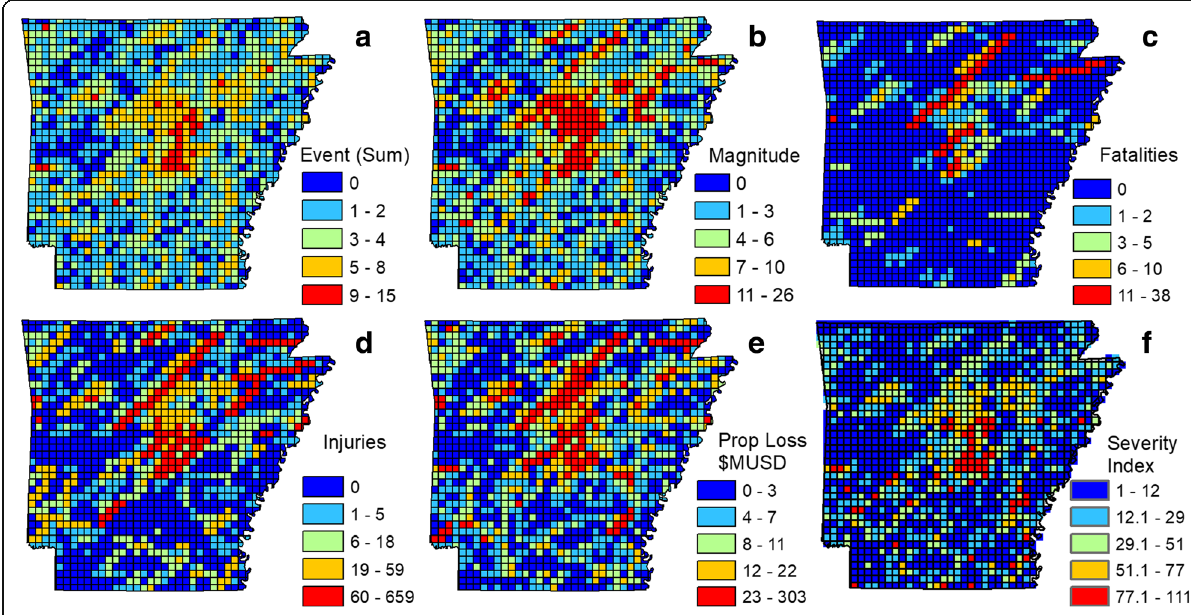
Fig. 6 Tornado Damage (grid cell = 10 × 10 km): a Sum of all events (frequency) b Sum of EF tornado magnitudes c Fatalities (some grids approach 40 fatalities over the 60-yr study period) d Injuries (many grids show 650+ injuries over the study period) e Property damage follows the same path of the largest magnitude tornadic events f Tornado severity